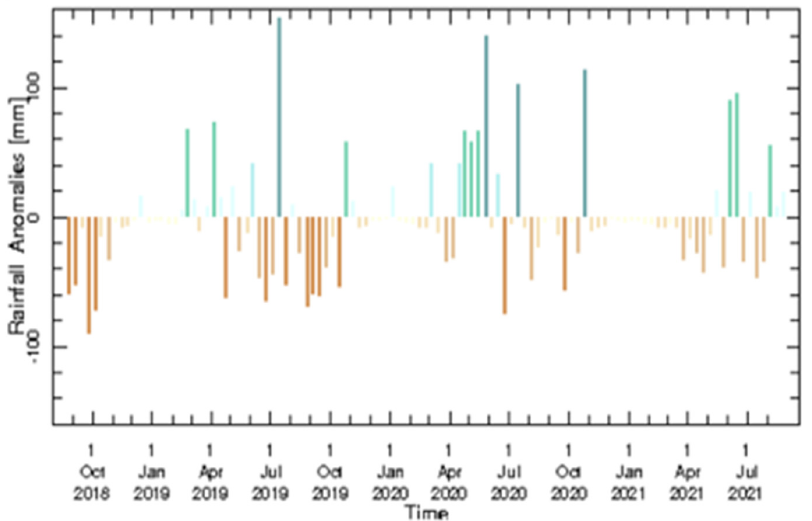
Figure 8. Dekadal rainfall anomalies for the selected region over Bangladesh over the last 3 years. For each year, the bars show whether dekadal rainfall for a given year was above normal (brown colors) or below normal (green colors). The length of the bars shows how much below or above normal the seasonal rainfall for a given year